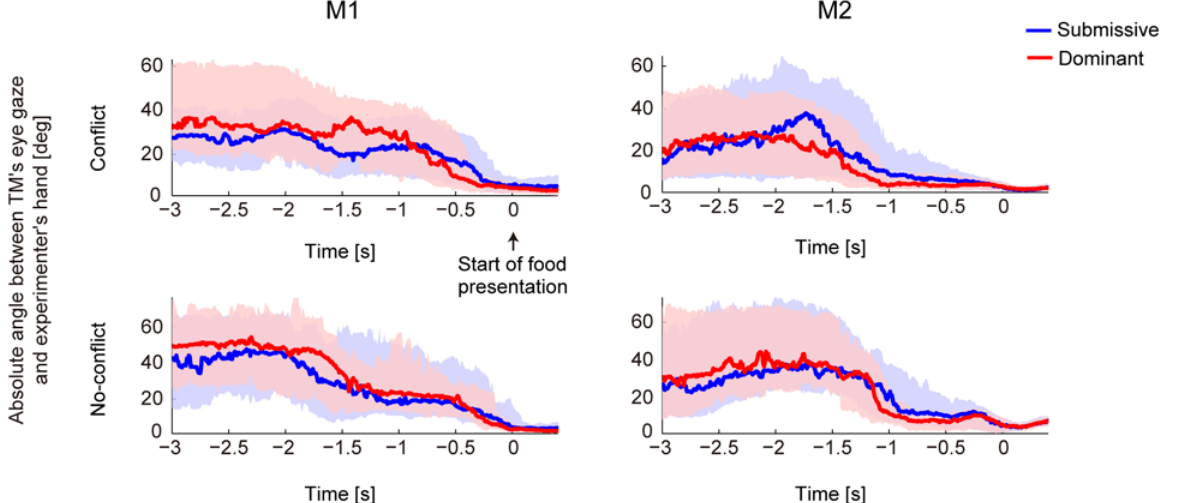
Fig 5. Temporal changes in eye gaze of the TM. The absolute values of the horizontal visual angle between the TM ’ s eye gaze and the top of the experimenter ’ s right hand were calculated for the conflict and no-conflict conditions for monkeys M1 and M2. In the conflict condition, the trials for the right and left conflict spaces were combined into one condition. The experimenter put his right hand under the table during the waiting and food-preparation periods, and the experimenter ’ s hand appeared above the table and the food was held in the right hand during the food-presentation period. The smaller angle around the start of the food-presentation period means that the TM always looked at the food. The blue and red lines represent the median angle for the submissive and dominant conditions, respectively. The lower and upper values of the shaded areas around the plots show the first and third quartiles of the angles, respectively.